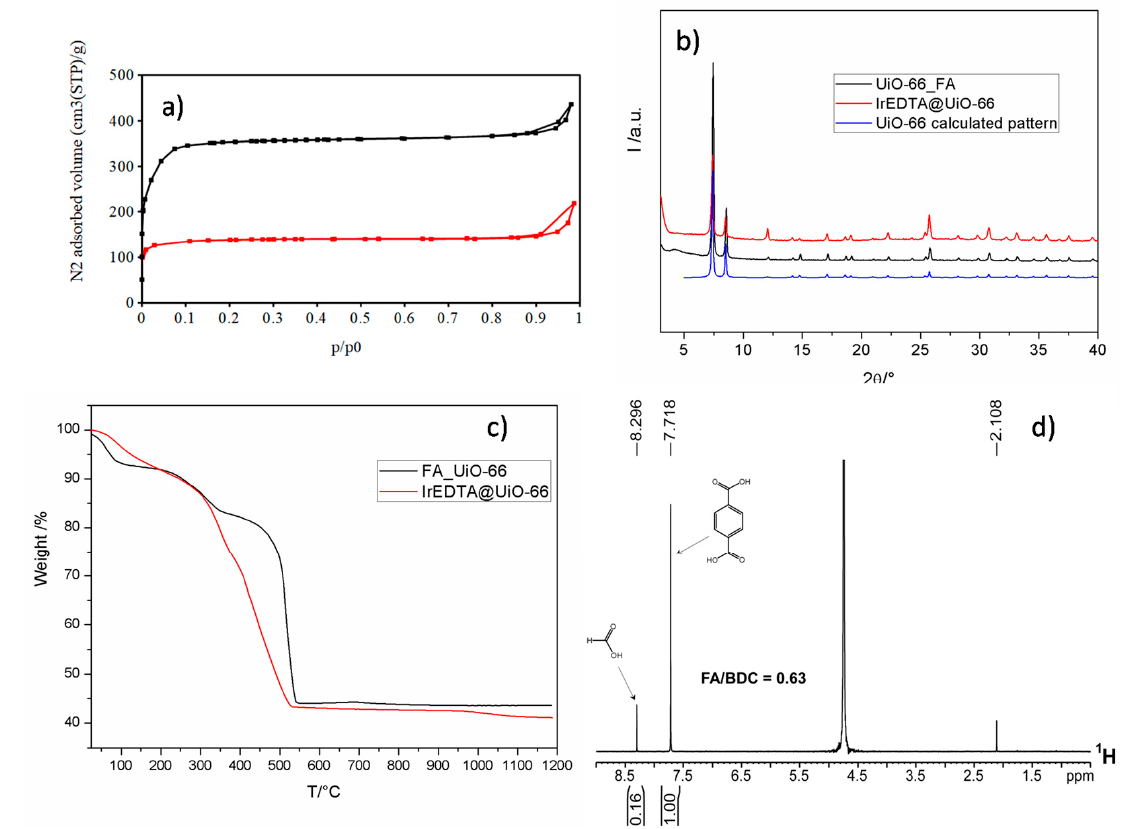
Figure 3. N 2 adsorption and desorption isotherm for FA_UiO-66 (black line) and IrEDTA@UiO-66 (red line) ( a ). XRPD patterns of FA_UiO-66 (black), Ir-EDTA@UiO-66 (red), and calculated pattern for UiO-66 (blue) ( b ). TGA curve for FA_UiO-66 (black) and IrEDTA@UiO-66 (red) ( c ) and 1 H-NMR spectrum for hydrolyzed FA_UiO-66 MOF (NaOD/D 2 O, 298 K) ( d ).